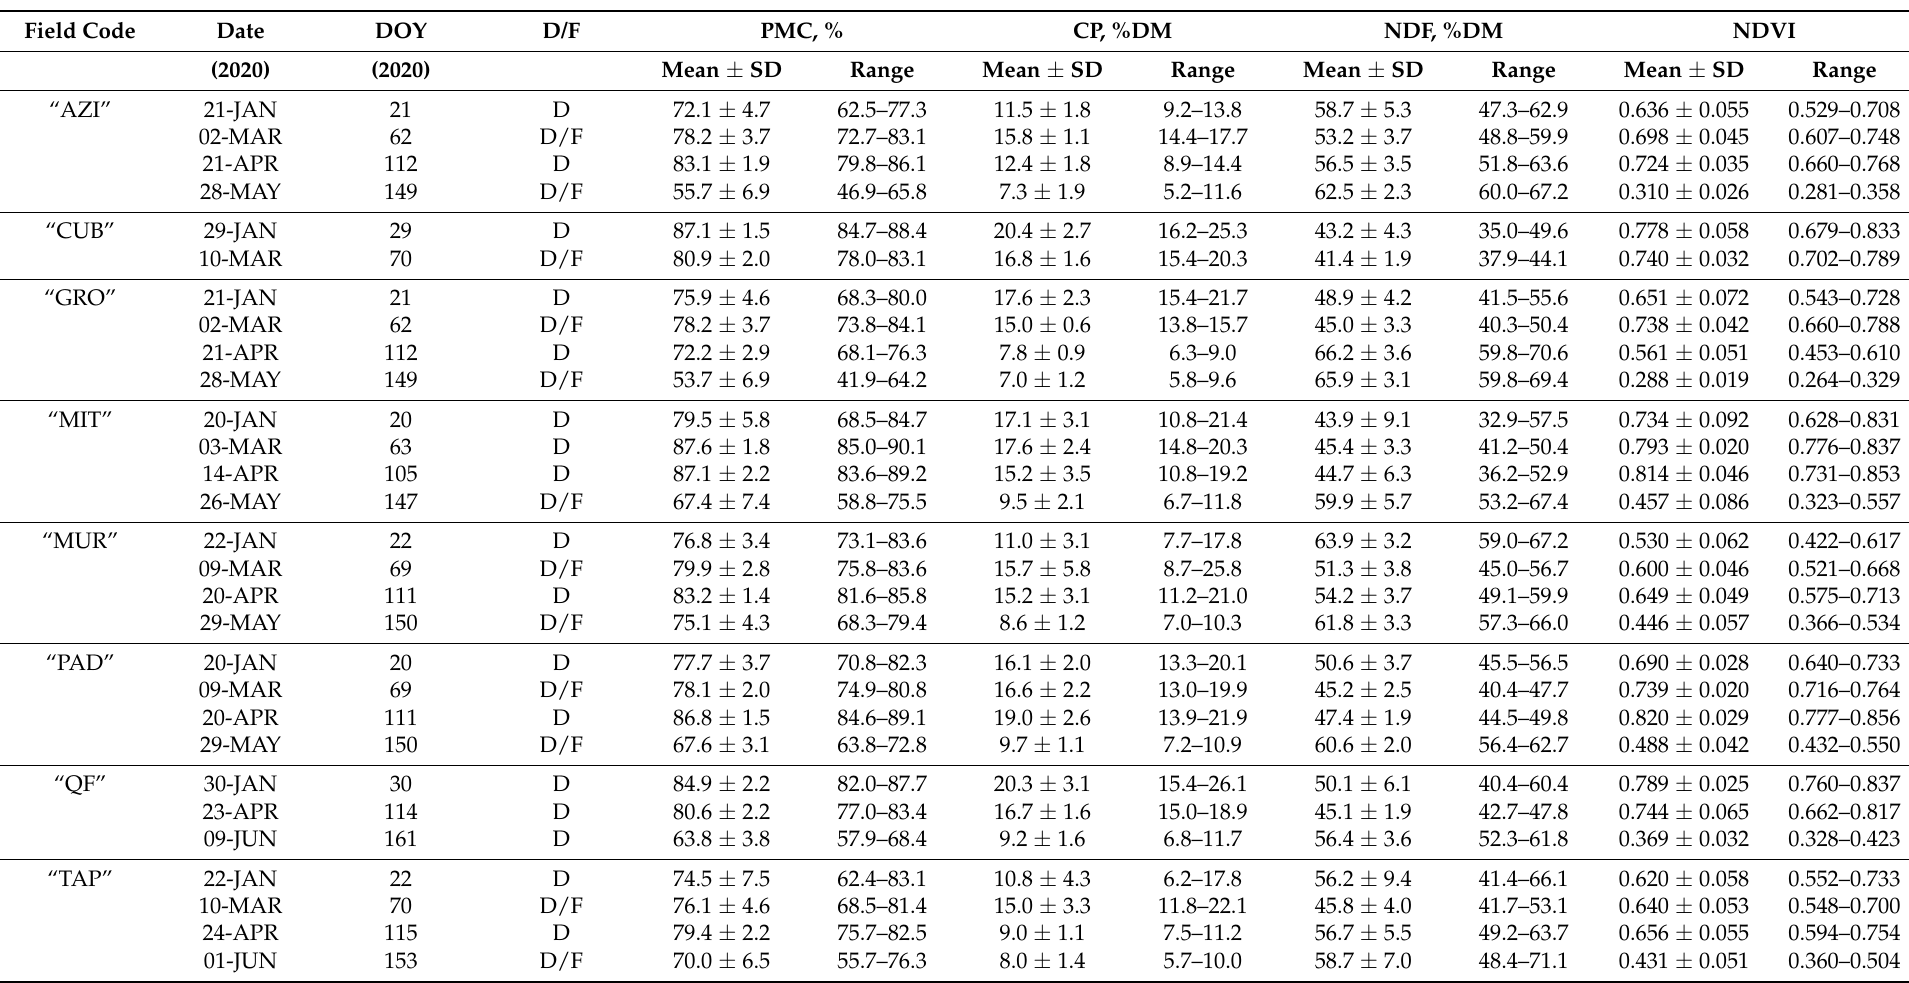
Table 1. Mean, standard deviation (SD), and range of pasture parameters in the 8 fields and on different dates for dry (D) and fresh (F)